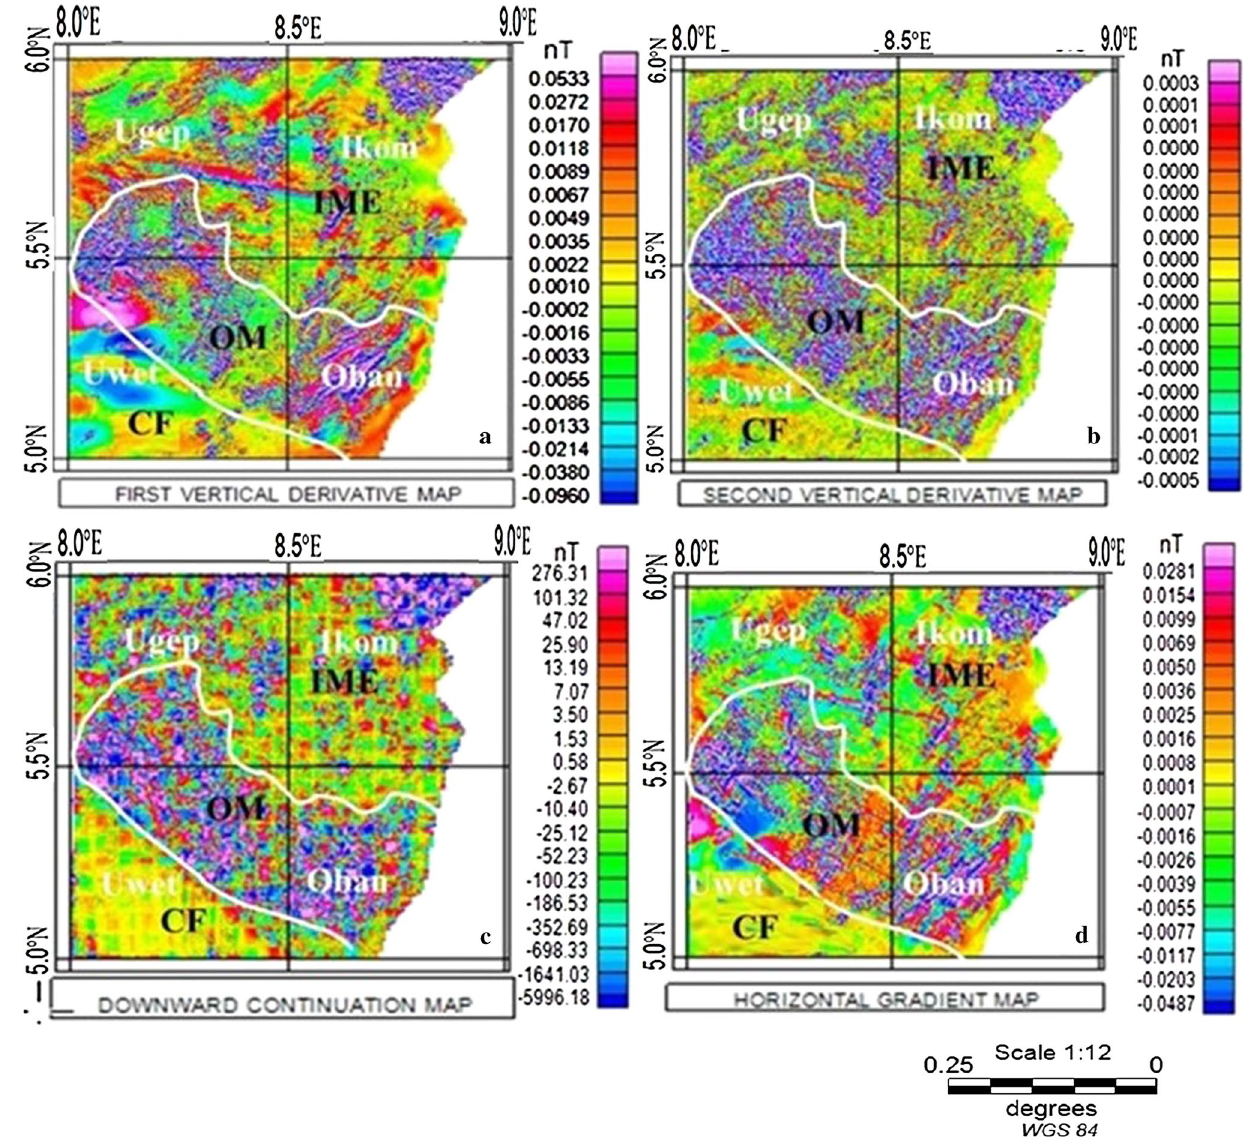
Fig. 10 Enhanced residual magnetic maps of a first vertical derivative, b second vertical derivative, c downward continuation and total horizon- tal